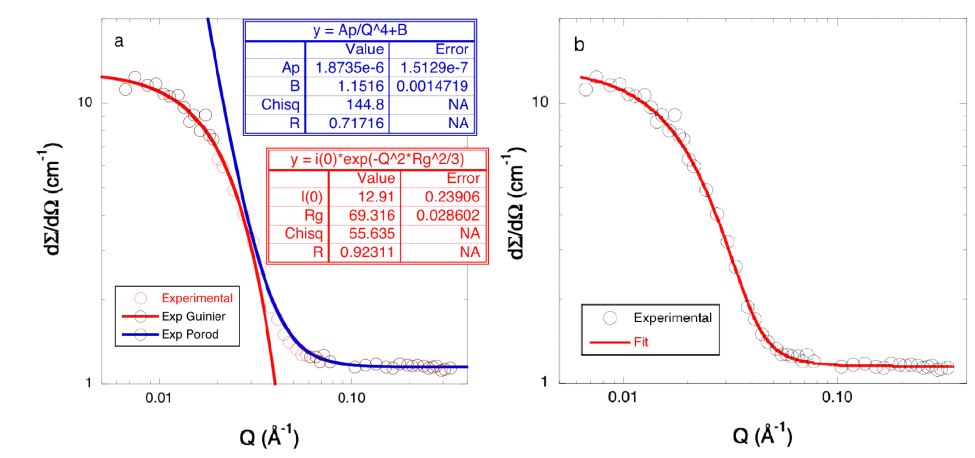
Figure 9. Analysis of experimental SCS of Ludox silica particles HS30 with a 0.3% volume fraction: ( a ) The SPA with the fits of the Guinier (red line), as well as of the Porod (blue line) approximations along with the values of the optimized parameters and their uncertainties. The points used for both fits are shown with black symbols, while the others are red. ( b ) A fitting procedure with a Weibull SDF, where corrections for the wavelength spread ( ∆ λ / λ = 18%) and for the multiple scattering were applied [29].